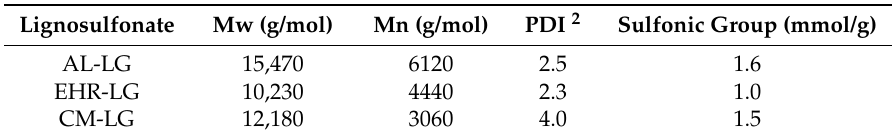
Table 1. Weight-average molecular weight (Mw), number-average molecular weight (Mn) and sulfonic group of AL-LG, EHR-LG, and CM-LG 1